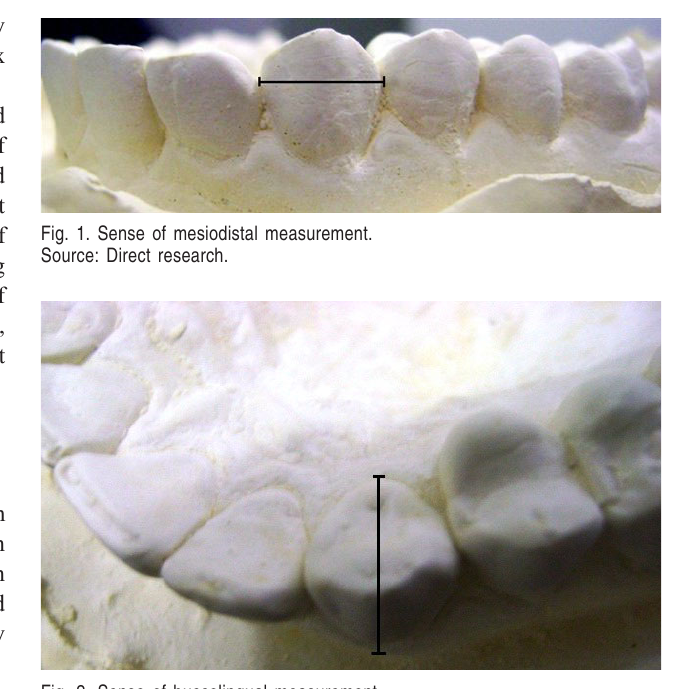
Fig. 2. Sense of buccolingual measurement. Source: Direct research.